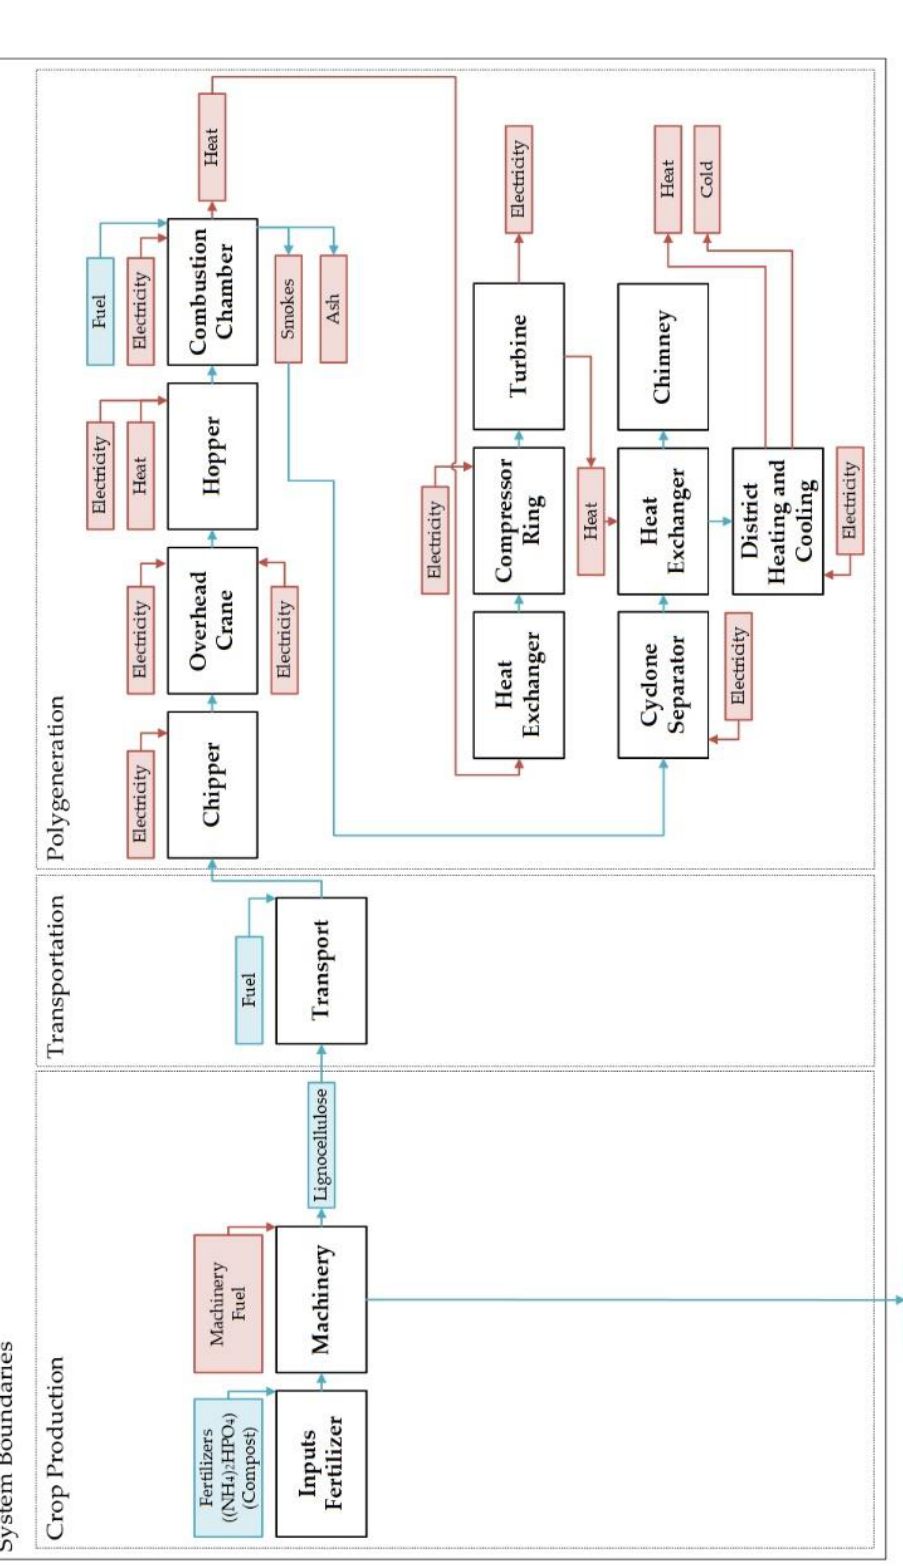
Figure 1. System boundaries — polygeneration chain. (Black — process steps/red — energy flows/blue — mass flows.)